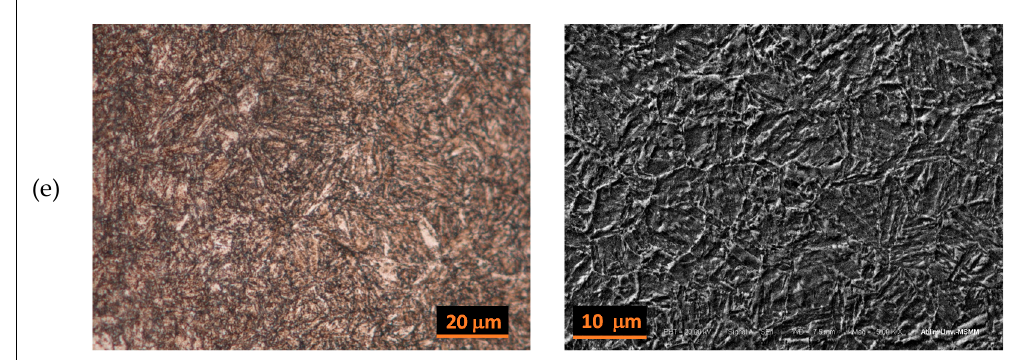
Figure 6. Optical (left) and SEM (right) microstructural images of the ballistic test samples; ( a ) IT-360, ( b ) IT-320, ( c ) IT-270, ( d ) IT-320-T, and ( e ) IT-270-T. Optical images were taken at 1000× and SEM images were taken at 5000× magnifications.